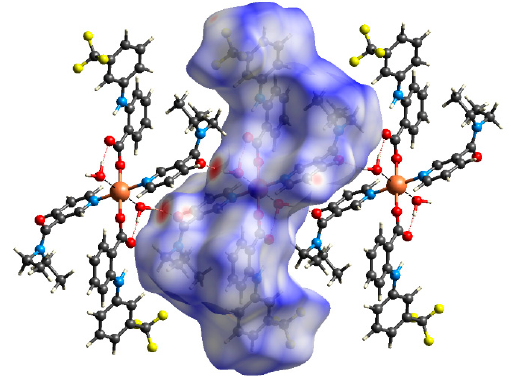
Figure 2. View of 3D Hirshfeld surface of 1 plotted over d norm in the range of − 0.5608 to 1.3607 a.u.